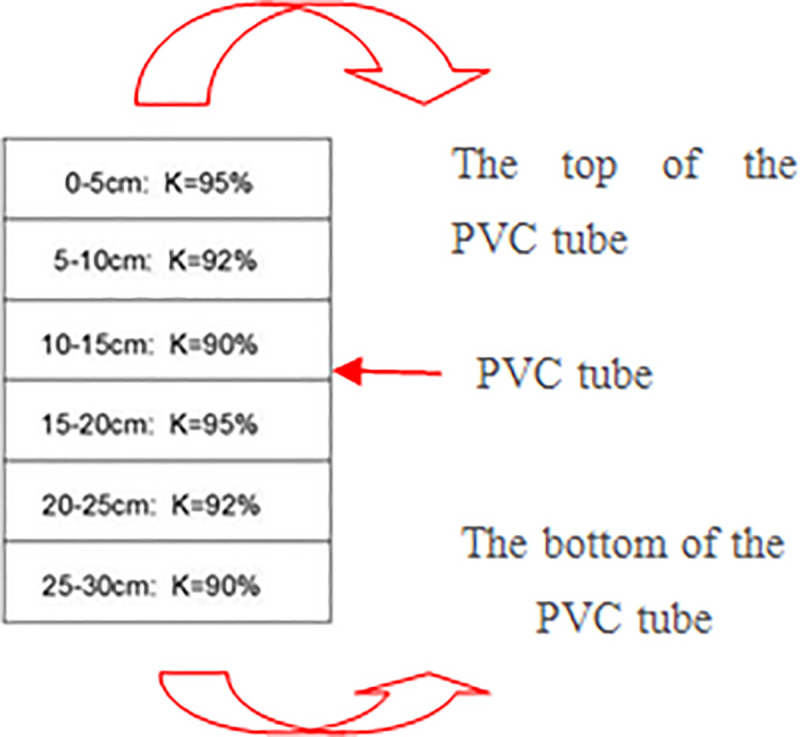
Compaction diagram.